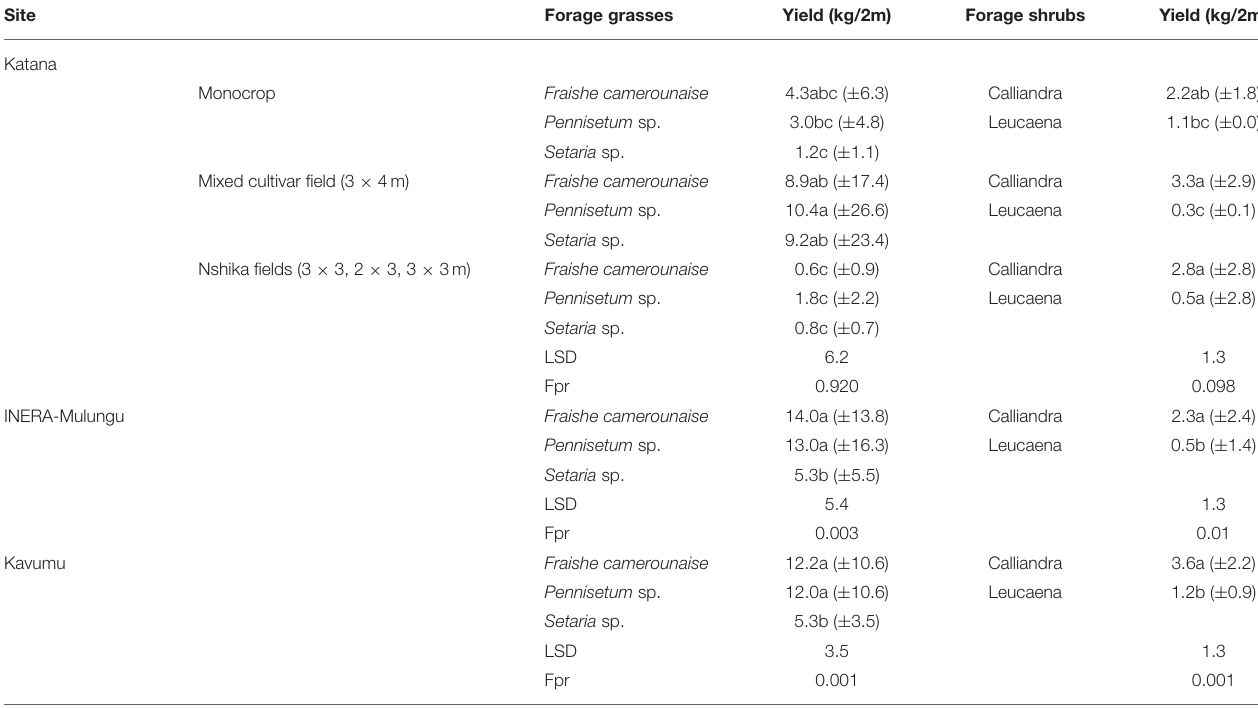
TABLE 7 | Biomass yields of forage grasses and shrubs included as border species across the sites INERA-Mulungu, Kavumu, and Katana center.